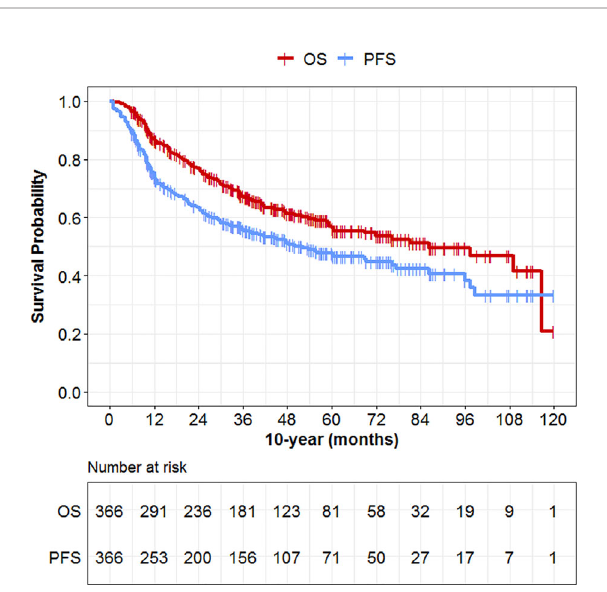
FIGURE 2 | Overall survival data of the 366 patients with laryngeal and hypopharyngeal